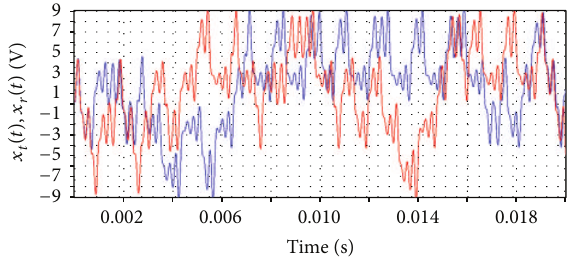
Figure 4: Time-domain chaotic waveforms for the transmitter (red line)andreceiver(blueline)circuitswiththesynchronizationcircuit